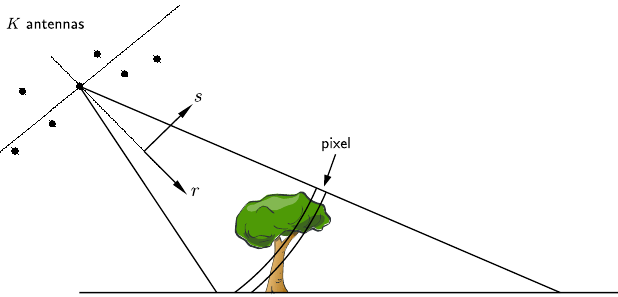
Figure 1. Illustration of the principle of TomoSAR imaging. Here, r and s denote the slant range and elevation coordinates in the radar reference system. All the scatterer contributions contained in a pixel centered around a particular azimuth-range position are superposed. TomoSAR uses several acquisitions at a slightly different incidence angle to reconstruct the reflectivity profile along the elevation direction s